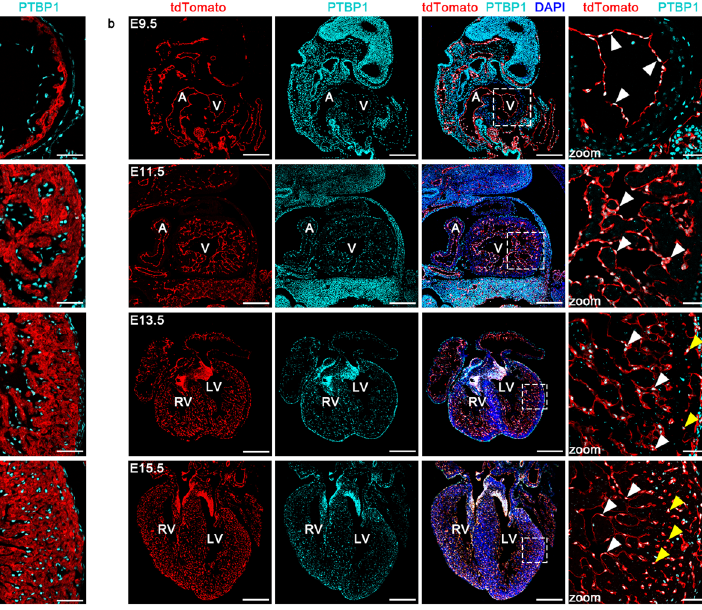
Cre ; Rosa26 -tdTomato ventricles. The white arrowheads indicate the colocalization of PTBP1 with endocardial cells; the yellow arrowheads indicate the colocalization of PTBP1 with endothelial cells in the compact myocardium. Scale bars in E9.5 and E11.5imagesare200 µ m;ScalebarsinE13.5andE15.5imagesare400 µ m;Scalebars in the zoomed images are 50 µ m. A atrium, V ventricle, LV left ventricle, RV right